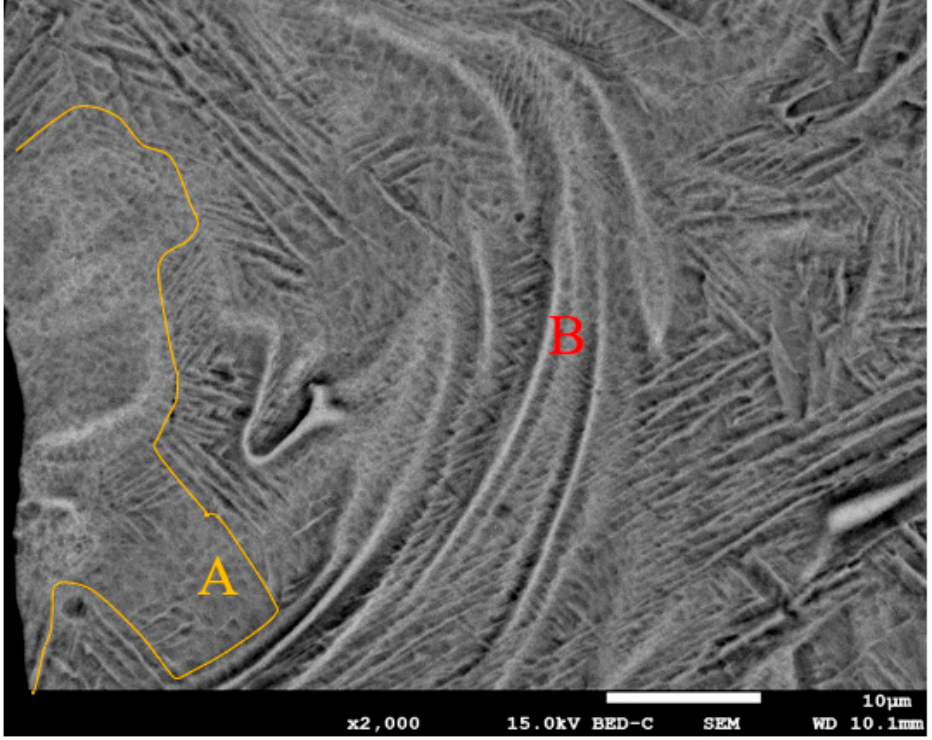
Figure 10. Solidification structure of the Ti5Mo alloy.